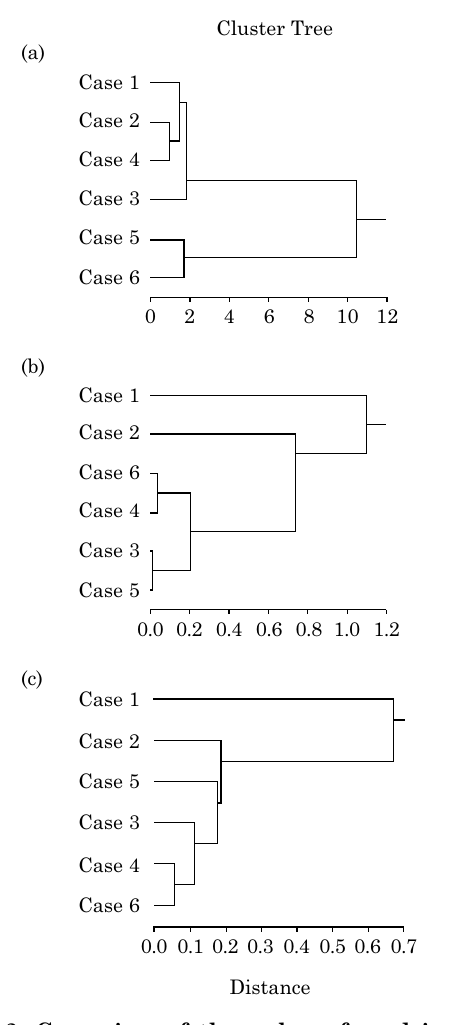
figure 2. grouping of the values found in the fertilizer line (a), at a distance of 3 m from the fertilizer line (b) and at a distance of 6 m from the fertilizer line (c), in all plots.